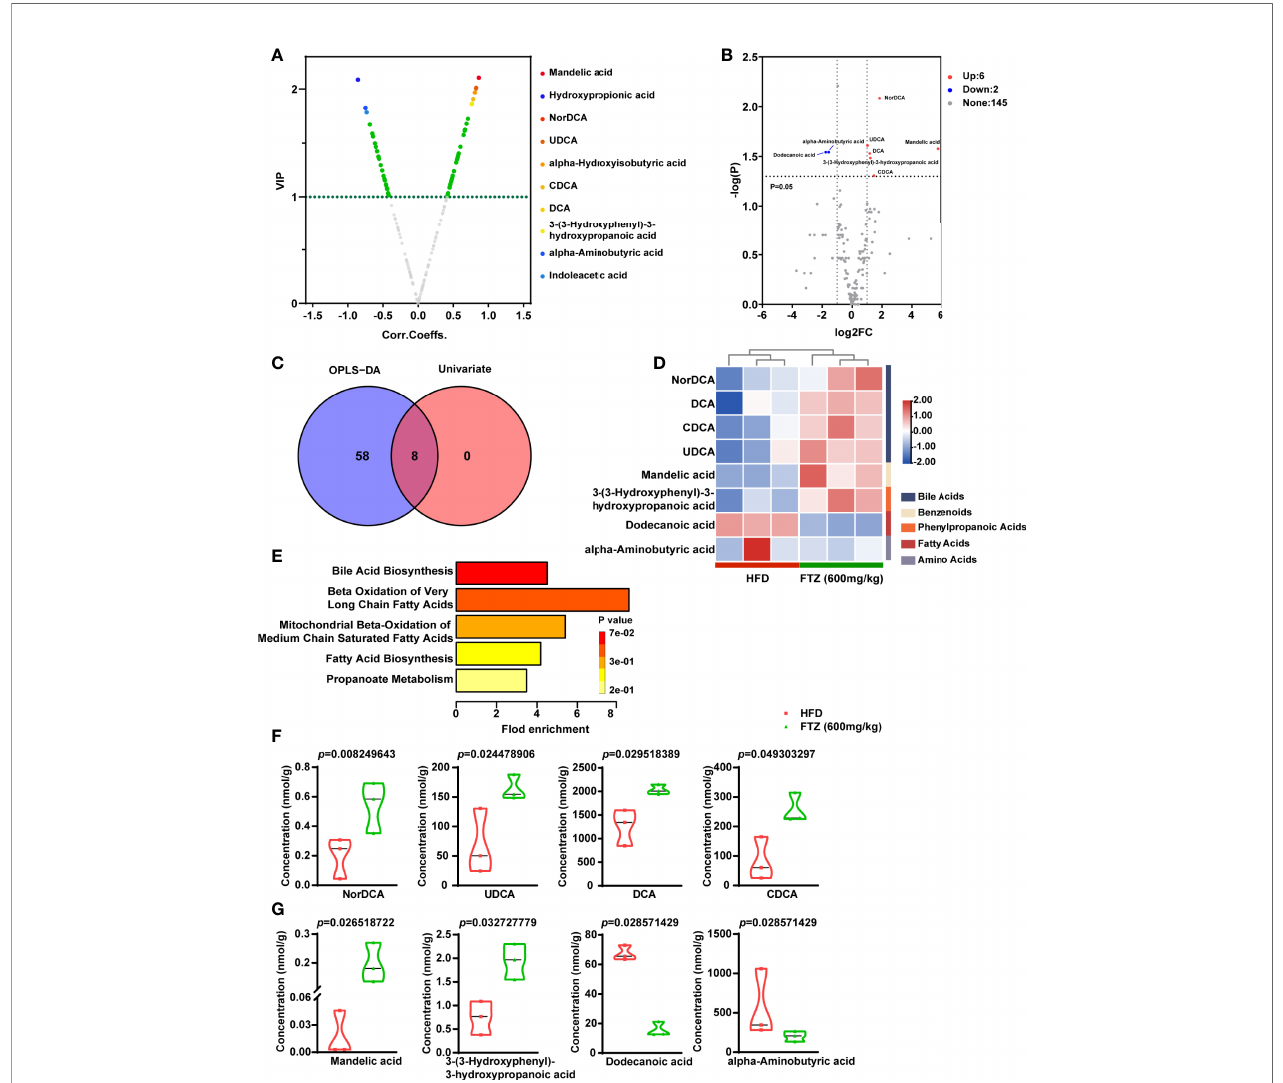
FIGURE 8 | Effects of FTZ on the potential biomarkers of intestinal metabolites in mice. (A) Volcano map based on OPLS-DA model results (VIP) > 1. (B) Volcano plot based on a one-dimensional test with the threshold set as follows: 1) P < 0.05 (t-test or Mann – Whitney U test); 2) absolute value of log2FC >1. (C) Venn diagram and the corresponding scores of the differential metabolites based on the data from the OPLS-DA model and one-dimensional test. (D) Z-score heat map of potential biomarkers (n=3). (E) Results of the pathway enrichment analysis of differential metabolites using selected SMPDB libraries (hypergeometric test). (F – J) Unidimensional statistical analysis of violin plots for the top 8 differential metabolites in terms of p-value (t-test or Wilcox. test;